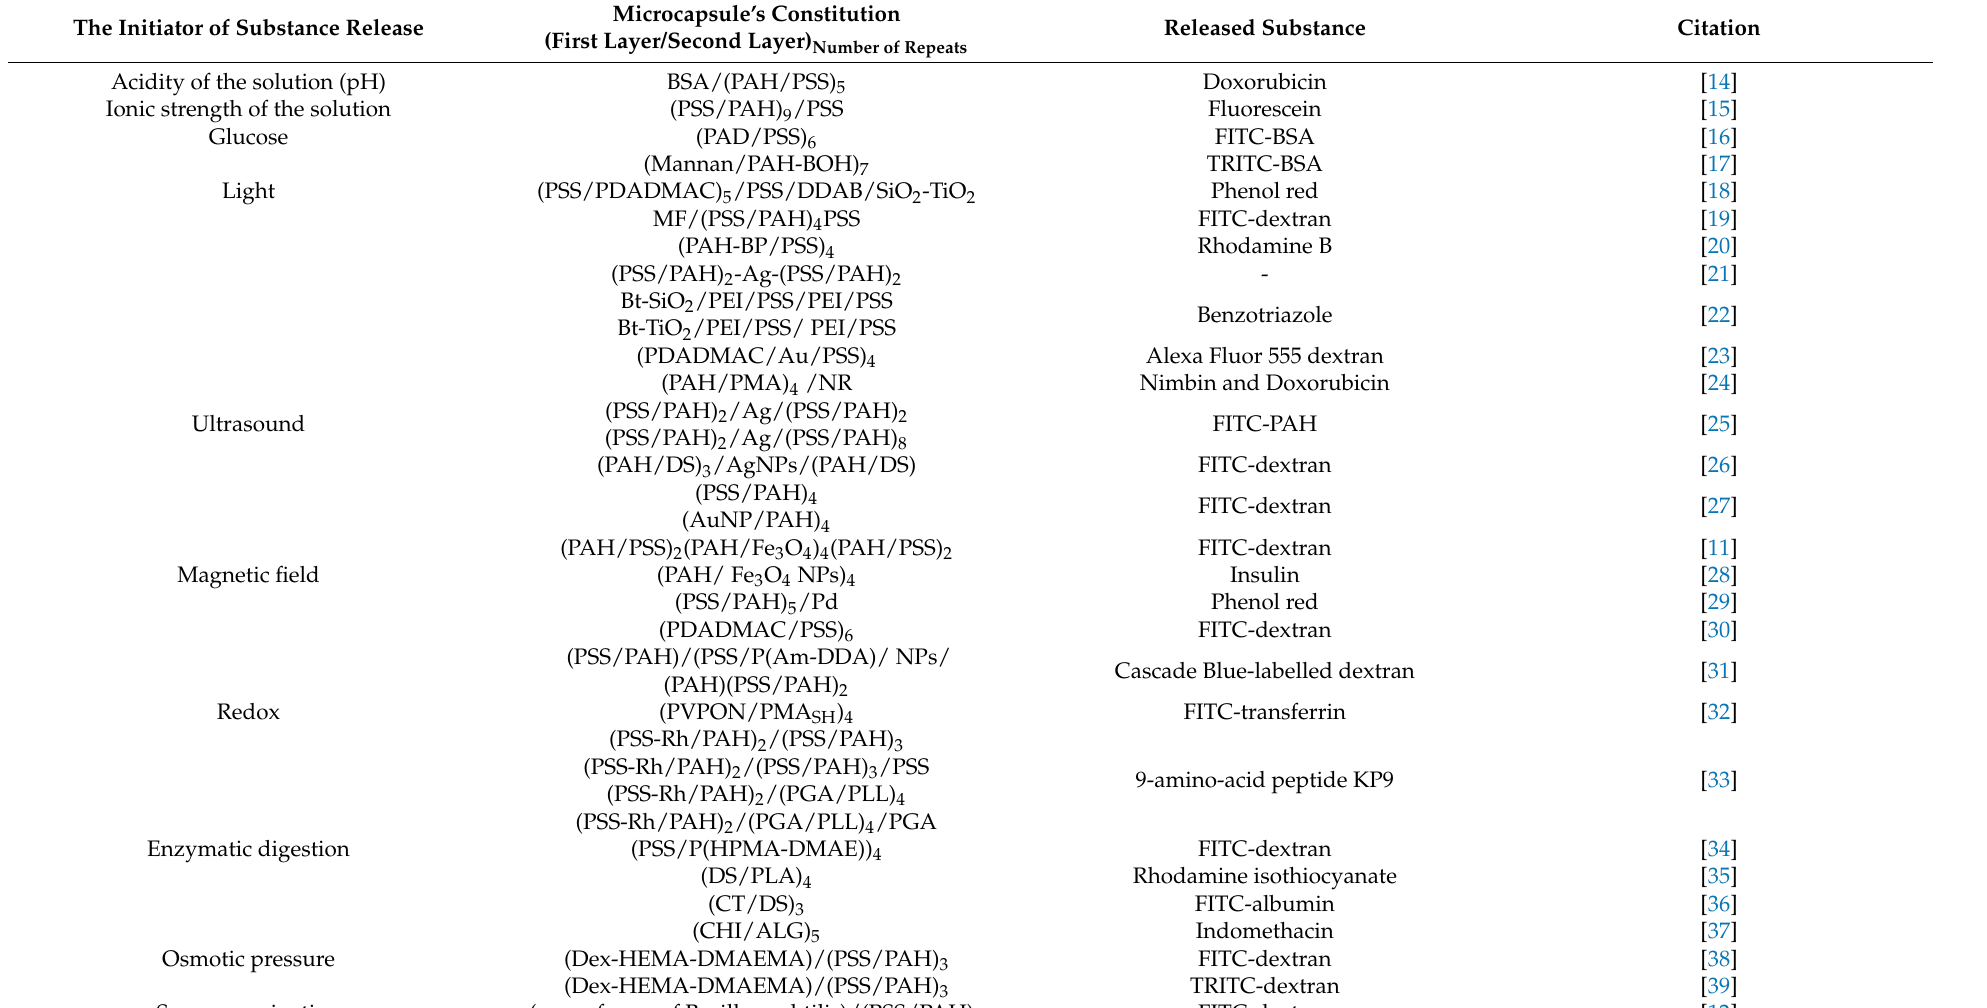
Table 1. Methods for controlled release of substances from polyelectrolyte